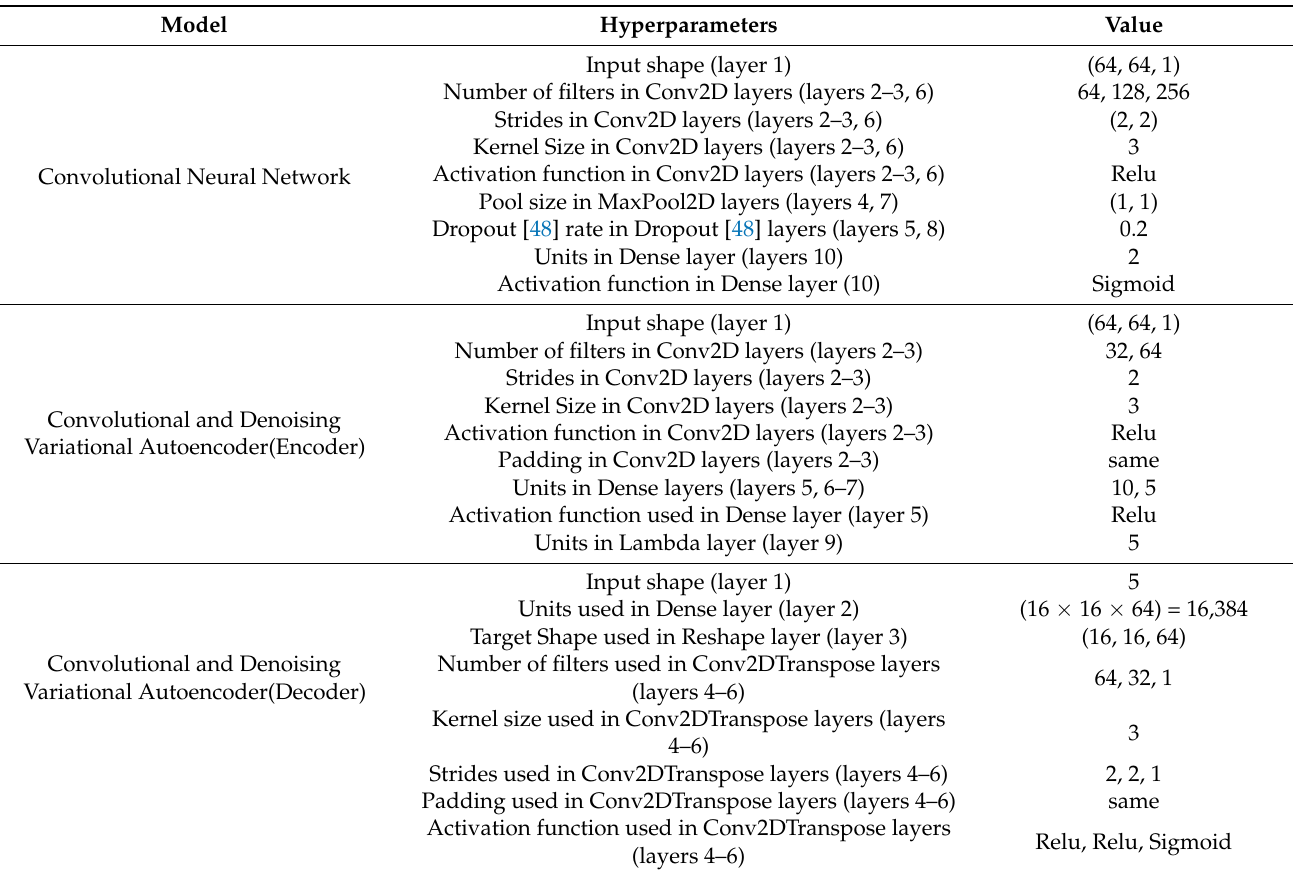
Table 2. Hyperparameters configuration of the proposed classification